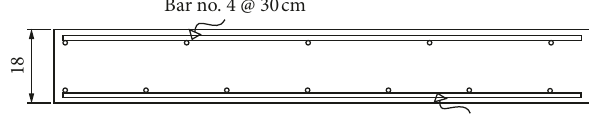
Figure 10: Slab section selected from the POS individuals, model